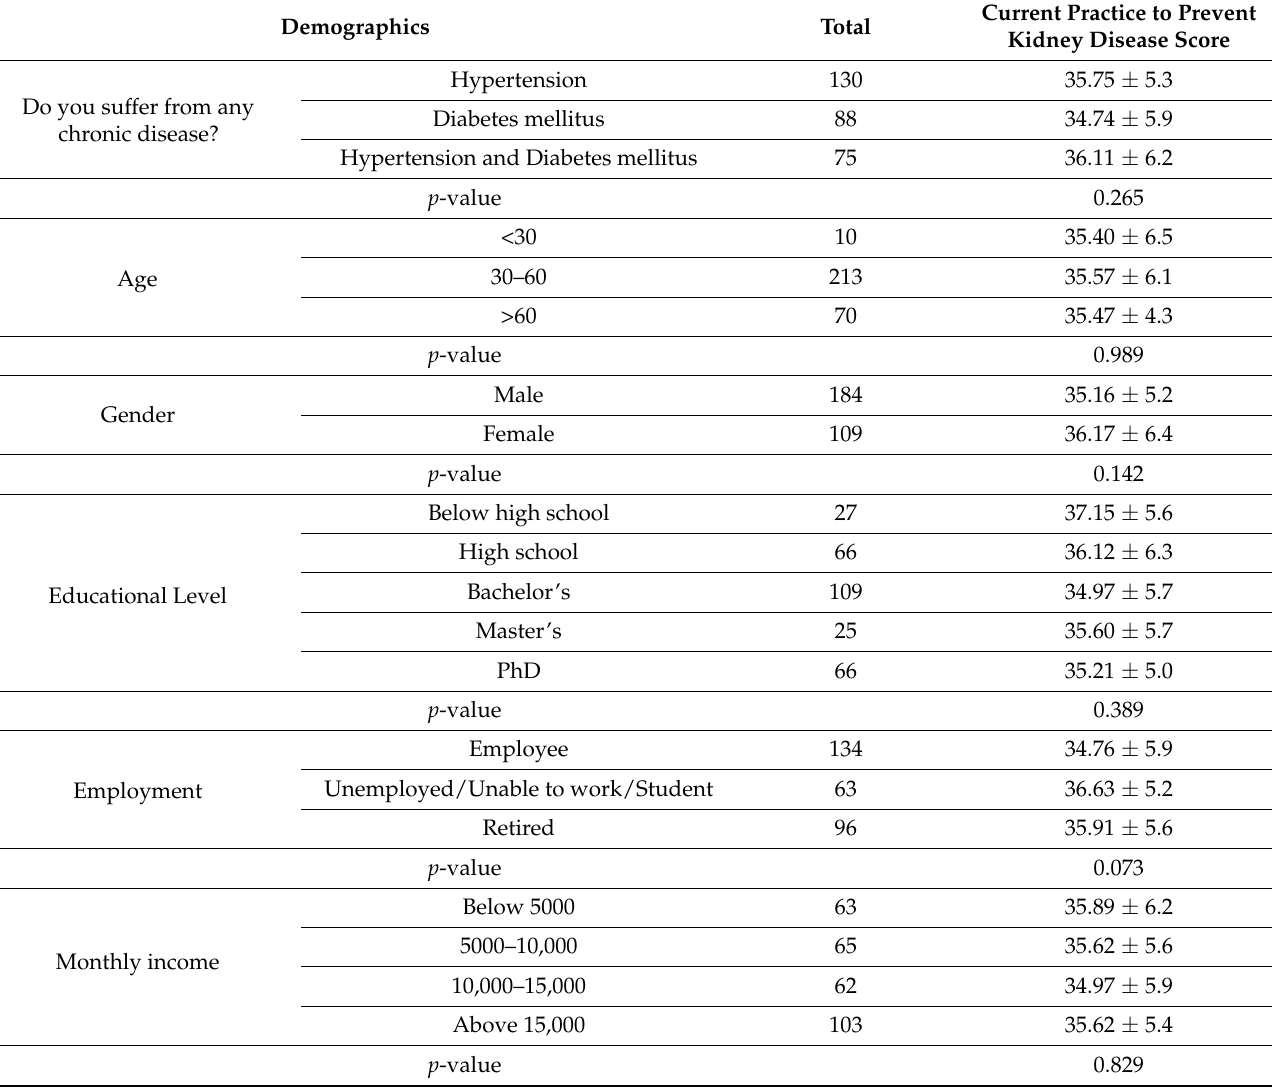
Table 4. Statistical analysis on participants’ current practice to prevent kidney